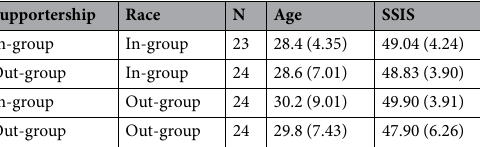
Table 1. Sample size, mean age and total scores on the SSIS reported for each experimental group separately. Standard deviations (SD) are given within brackets. SSIS = Sport Spectator Identification